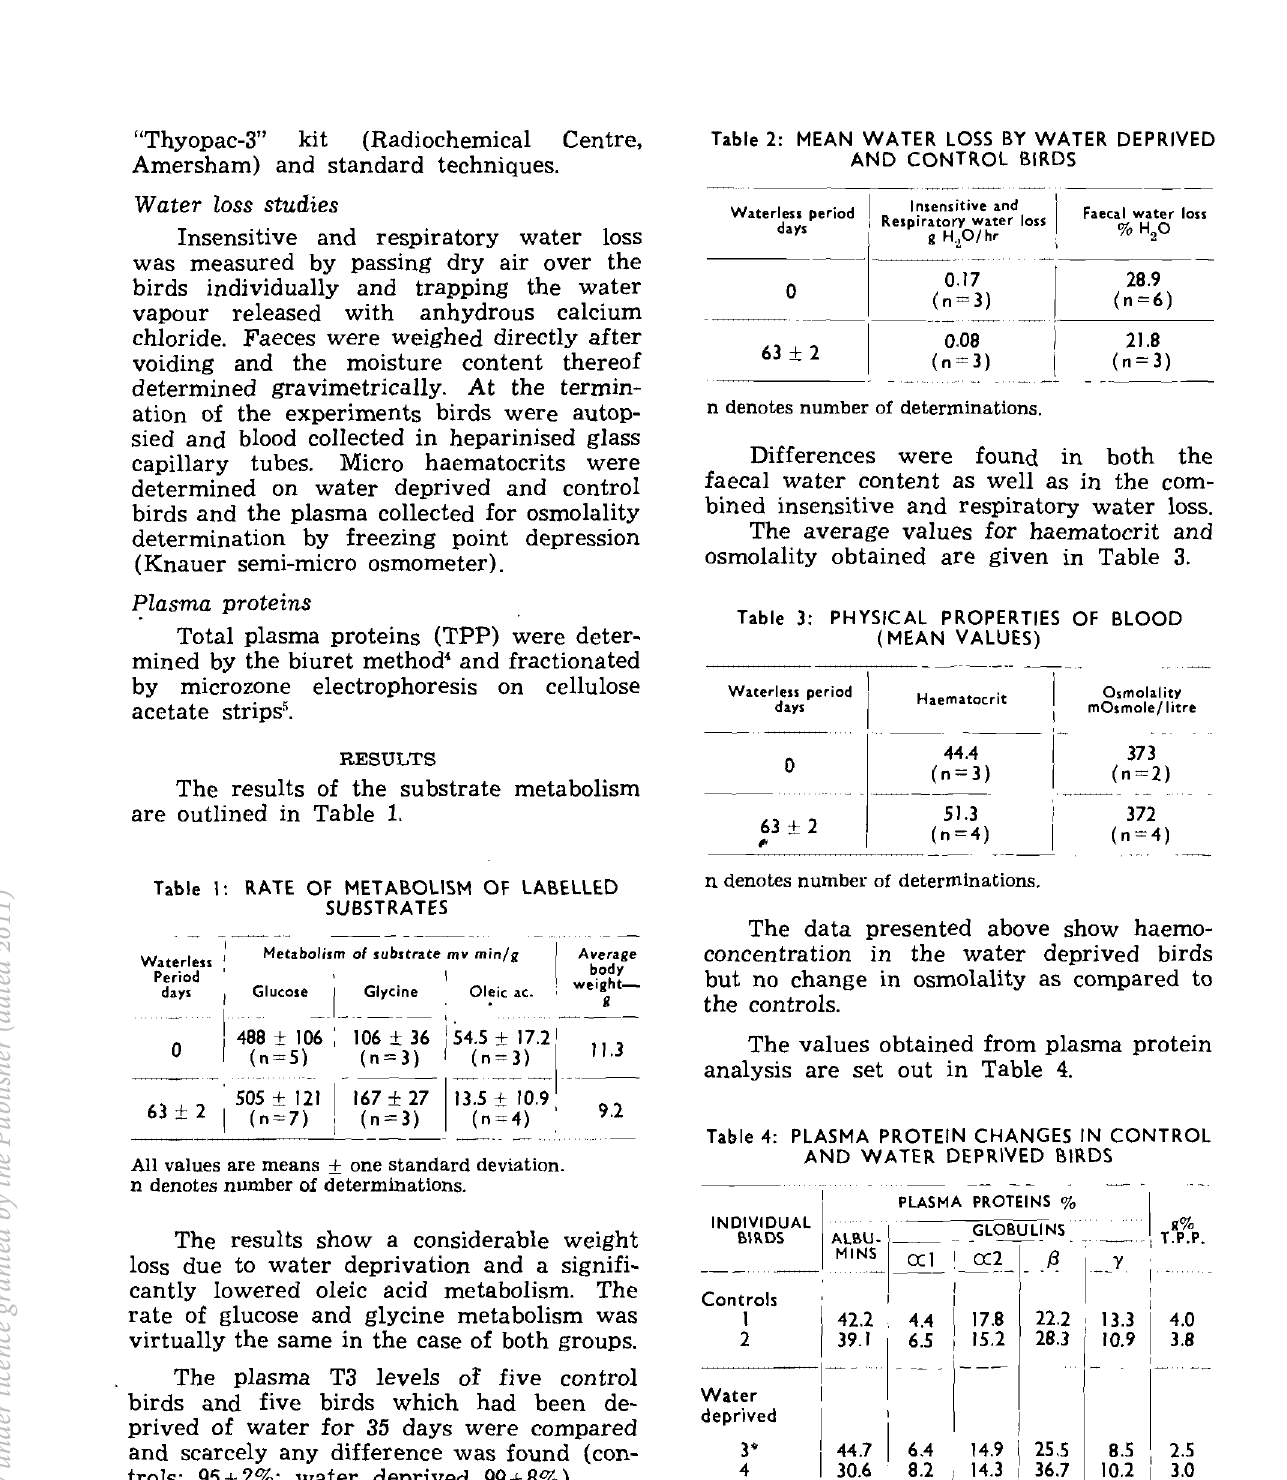
Table 2: MEAN WATER LOSS BY WATER DEPRIVED AND CONTROL BIRDS